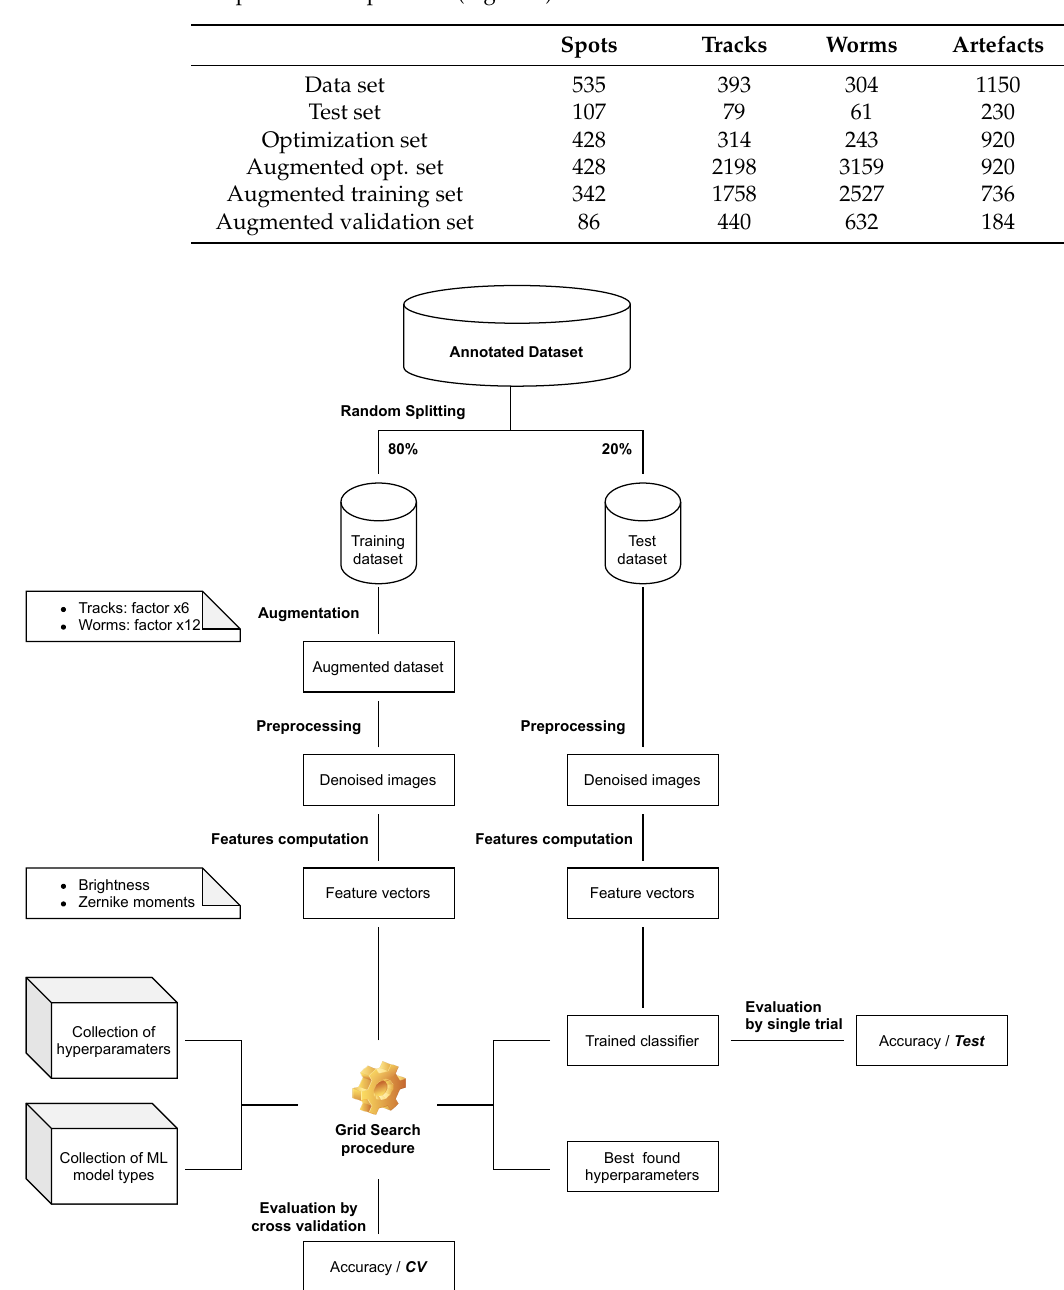
Table 3. Statistics describing the partitioning and augmentation scheme of the dataset used in the first phase of computation (Figure 9).